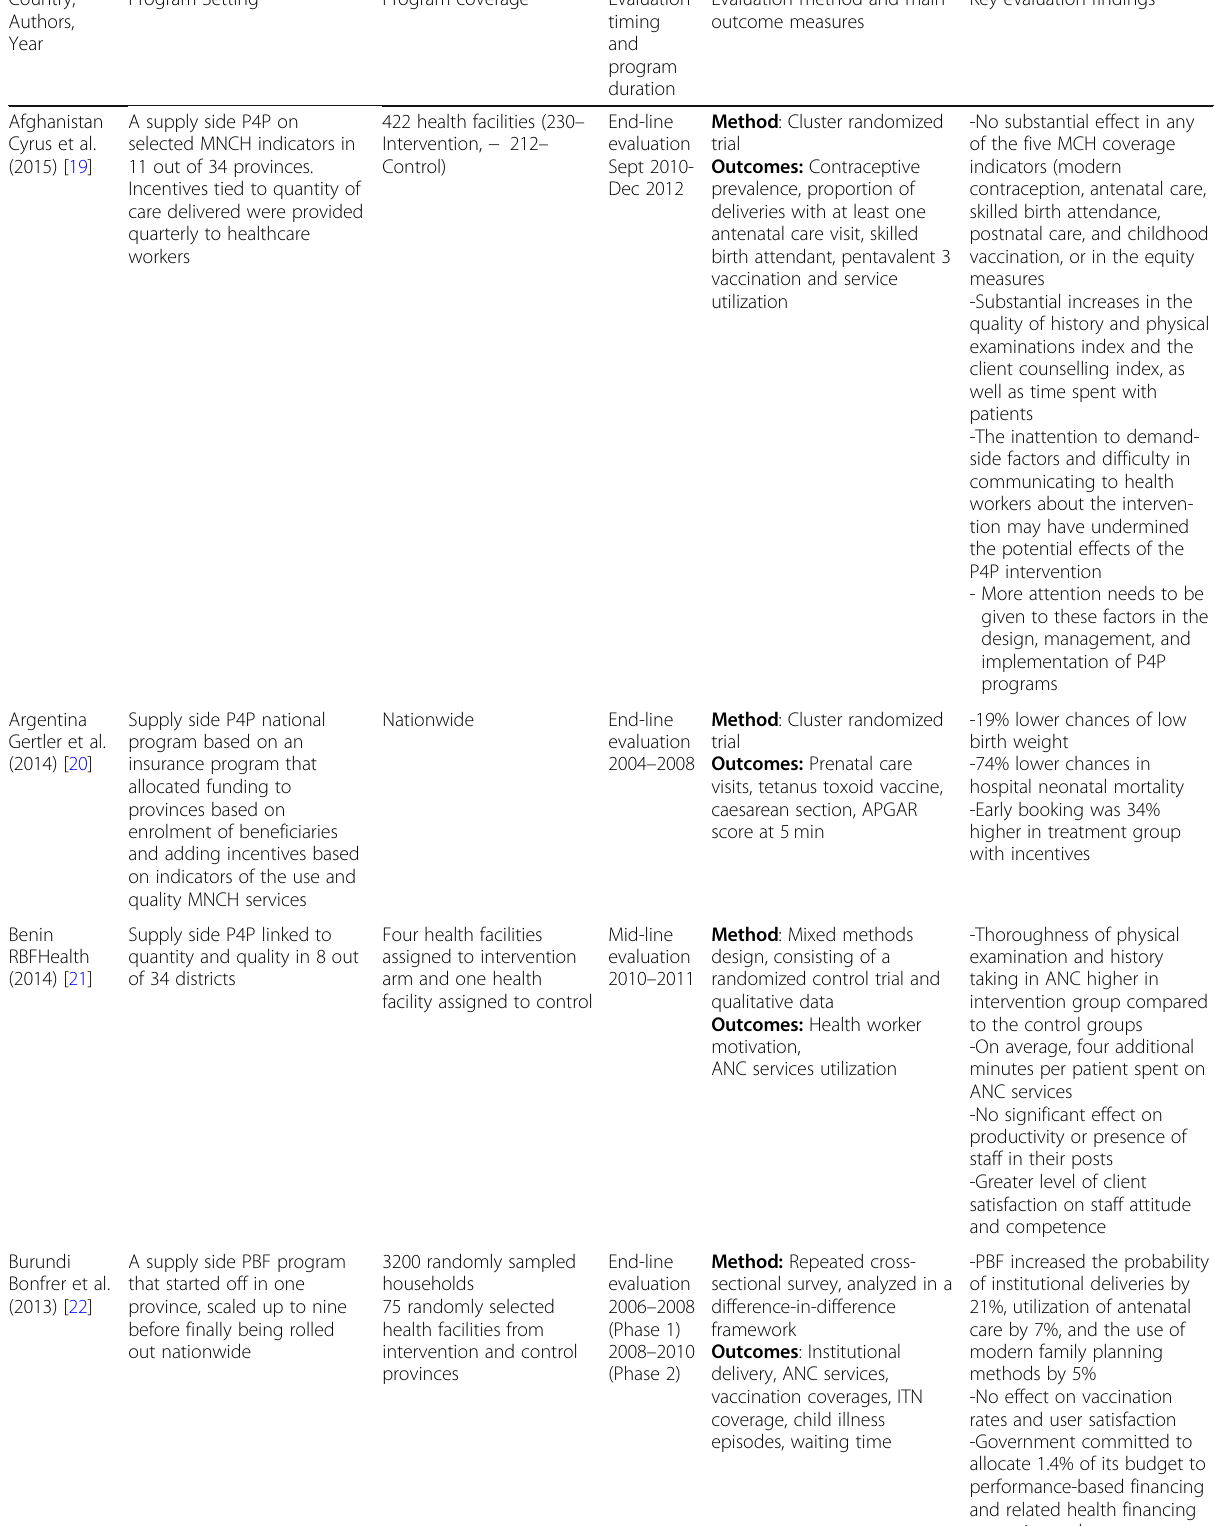
Table 1 Description of RBF evaluation reports including evaluation methods and key findings, by country Country,